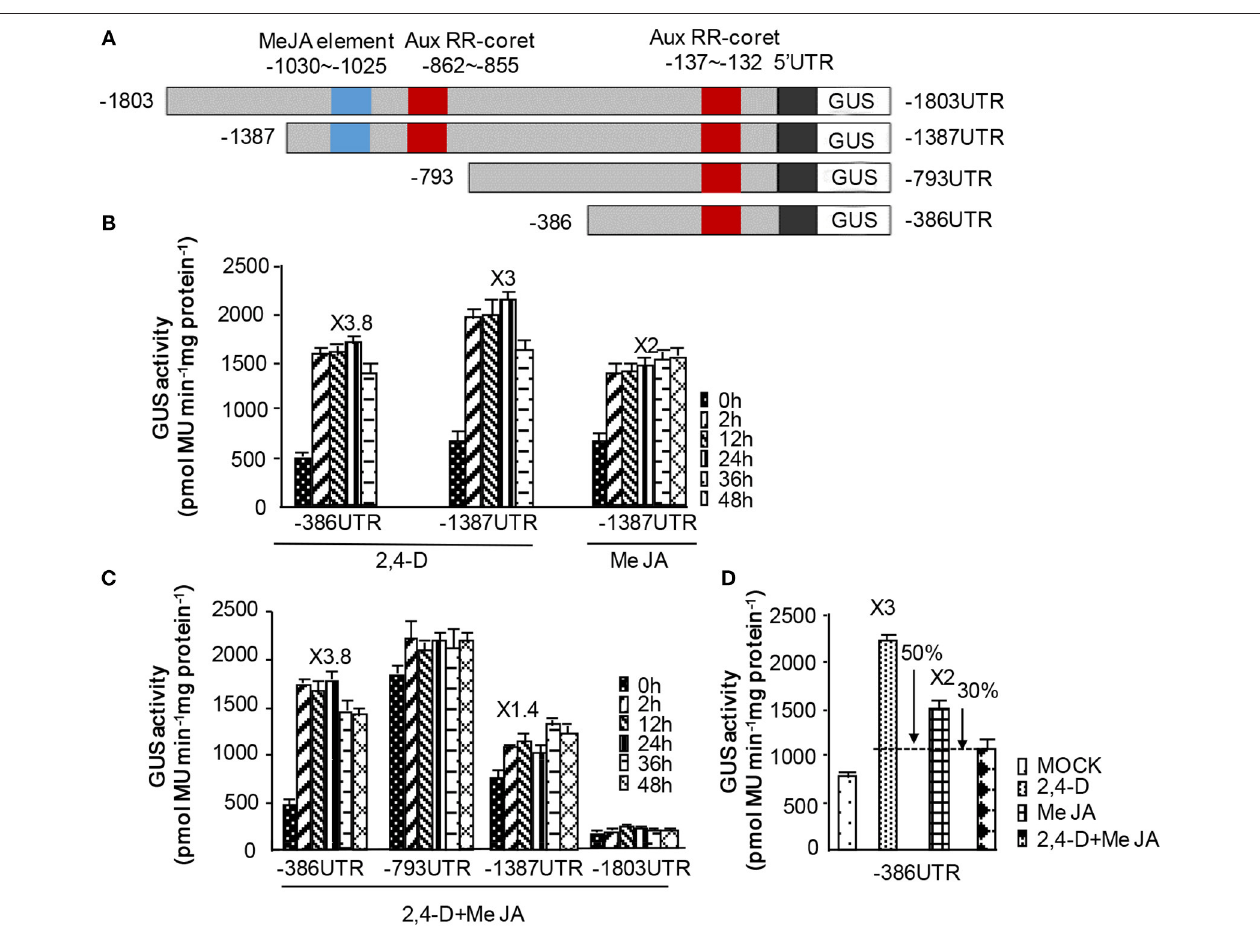
FIGURE 6 | The NtWRKY-R1 integrated the auxin and JA signaling. (A) The promoter fragments of NtWRKY-R1 . This promoter contains the MeJA and AuxRR elements. Schematic diagrams of NtWRKY-R1 promoter and its deletions were shown. (B–D) The GUS activities of the deleted and complete promoters were monitored. The deleted NtWRKY-R1 promoters were fused to GUS reporter gene, and then transformed into BY2 cell. We measured GUS activities at 0, 2, 12, 24, 36, and 48h after treatment with JA and/or